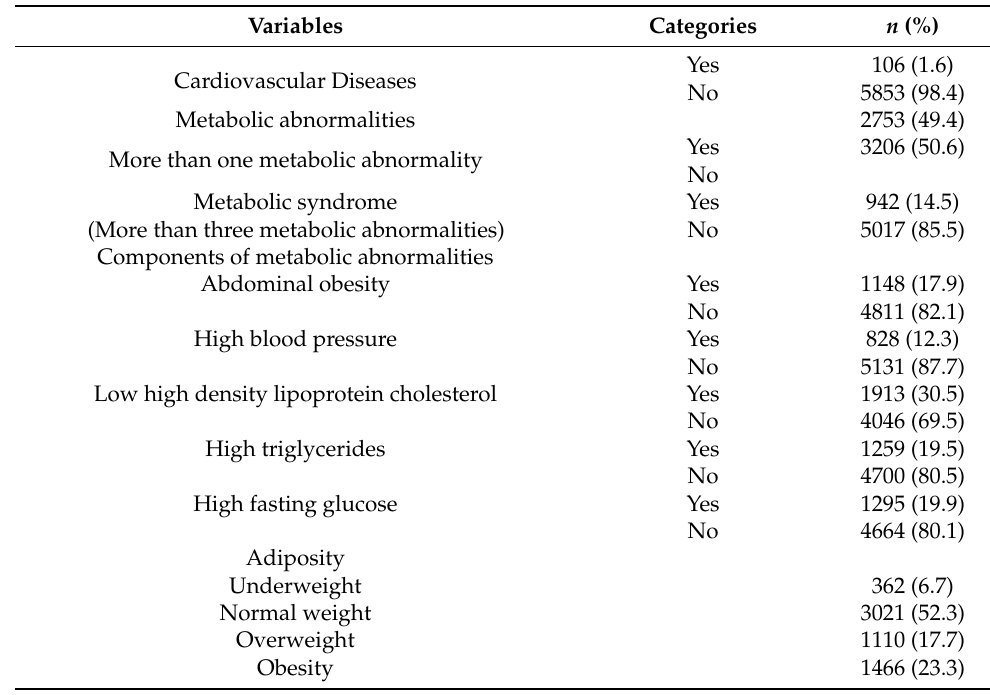
Table 1. Characteristics of cardiovascular diseases, metabolic abnormalities, adiposity, and covariates among the